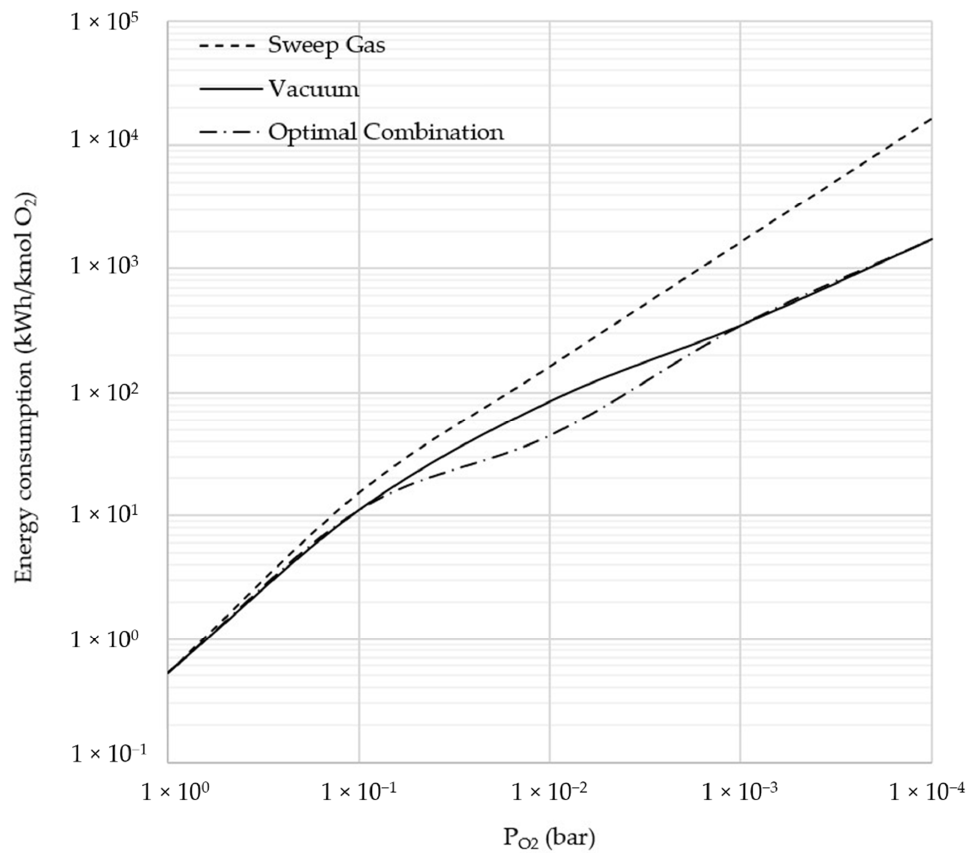
Figure 9. Energy consumption per mole of oxygen removed in a closed circuit of sweep gas as a function of oxygen partial pressure (P O2 ). The dotted line represents the use of sweep gas with different purities under constant atmospheric pressure, the solid line shows the use of different vacuum pressures without sweep gas and the dash-dotted line depicts the optimal combination of sweep gas and vacuum. The global pressure drop is assumed to be 100 mbar and the purification energy requirements, 4 kJ/mol N 2 .